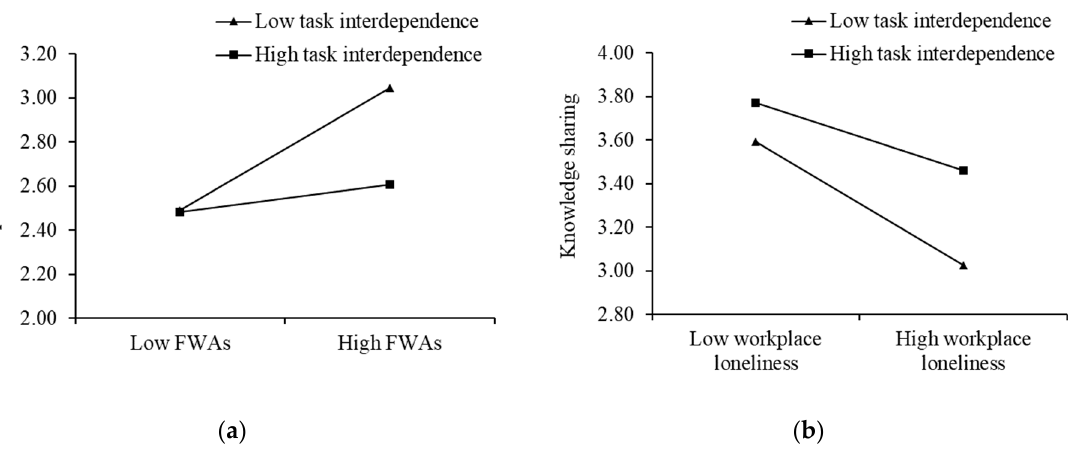
Figure 2. The moderating role of task interdependence in Study 1: ( a ) The moderating role of task interdependence on the relationship between FWAs and workplace loneliness; ( b ) The moderating role of task interdependence on the relationship between workplace loneliness and knowledge sharing.